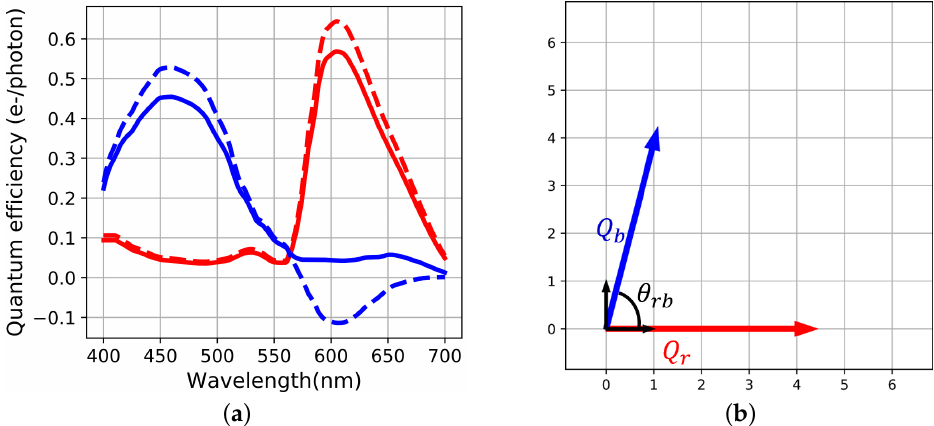
Figure 4. ( a ) Spectral sensitivities (continuous curves) and orthogonalized curves (dash curves, scaled by a factor five for visualization) ( b ) Corresponding geometrical representation. θ rb = 75 ◦ , the black arrows are the non-scaled vectors of the orthogonal